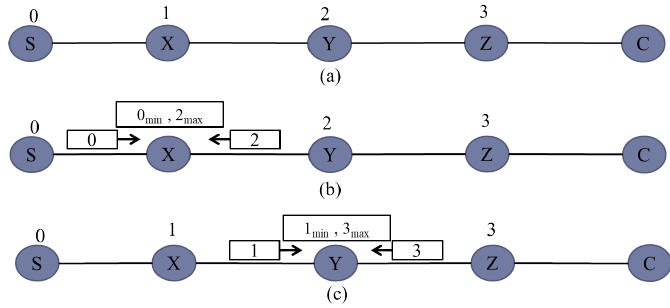
Figure 5. Minimum Maximum Neighbor selection